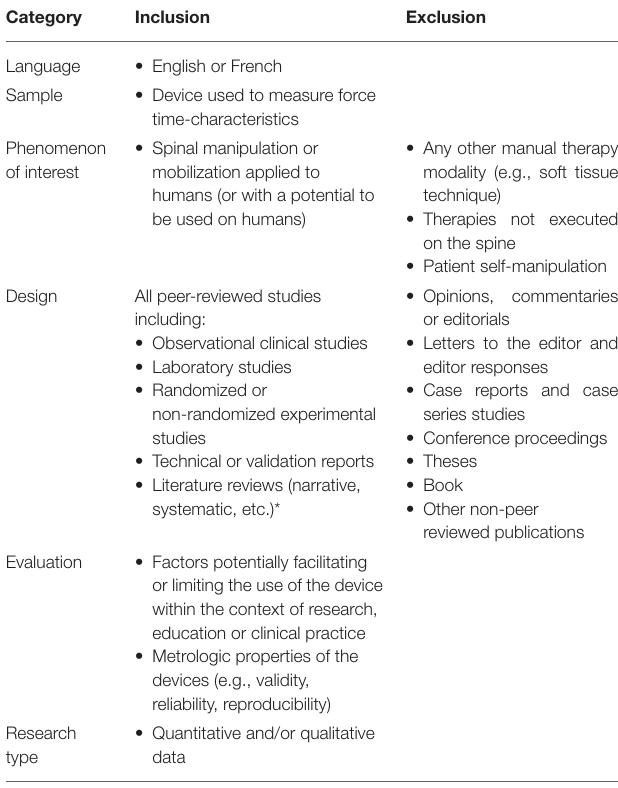
TABLE 1 | Inclusion and exclusion